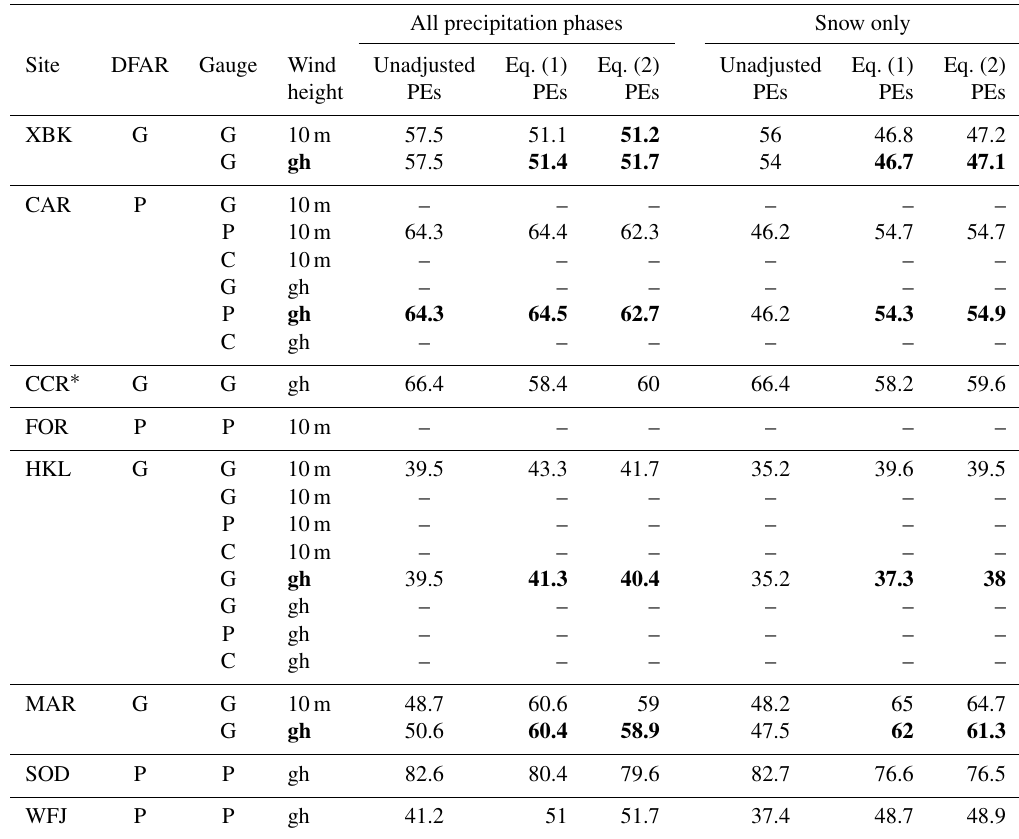
Table 9. Percentage of events (PEs) that differ from the DFAR by less than 0.1mm for the unshielded gauges (G – Geonor; P – Pluvio 2 ) at each site for the combined winters of 2015/2016 and 2016/2017 for available wind speed measurement heights (10m; gh – gauge height) and for Eqs. (1) and (2). Metrics are separated by precipitation phase (all and snow only). Where both wind speed heights are available, the gauge height data are shown in